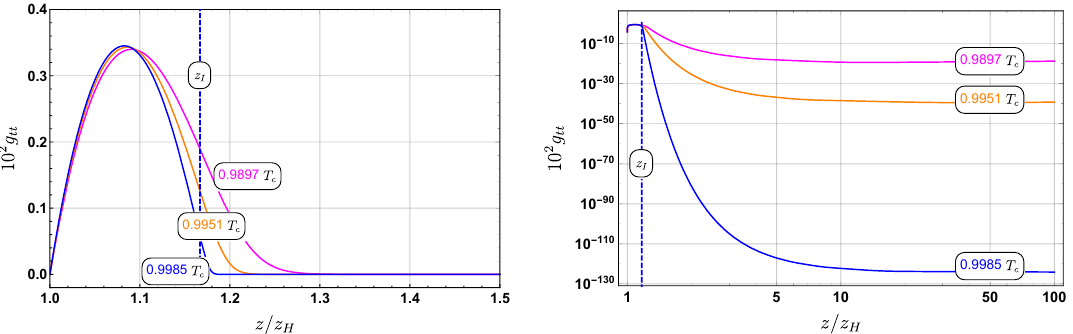
Figure 5 . Interior epoch for the ER collapse at different temperatures. g tt experiences a sudden drop to an exponentially small value in the vicinity of the would-be innner horizon z at T (the vertical dashed line). We set the chemical potential µ = 1 . c